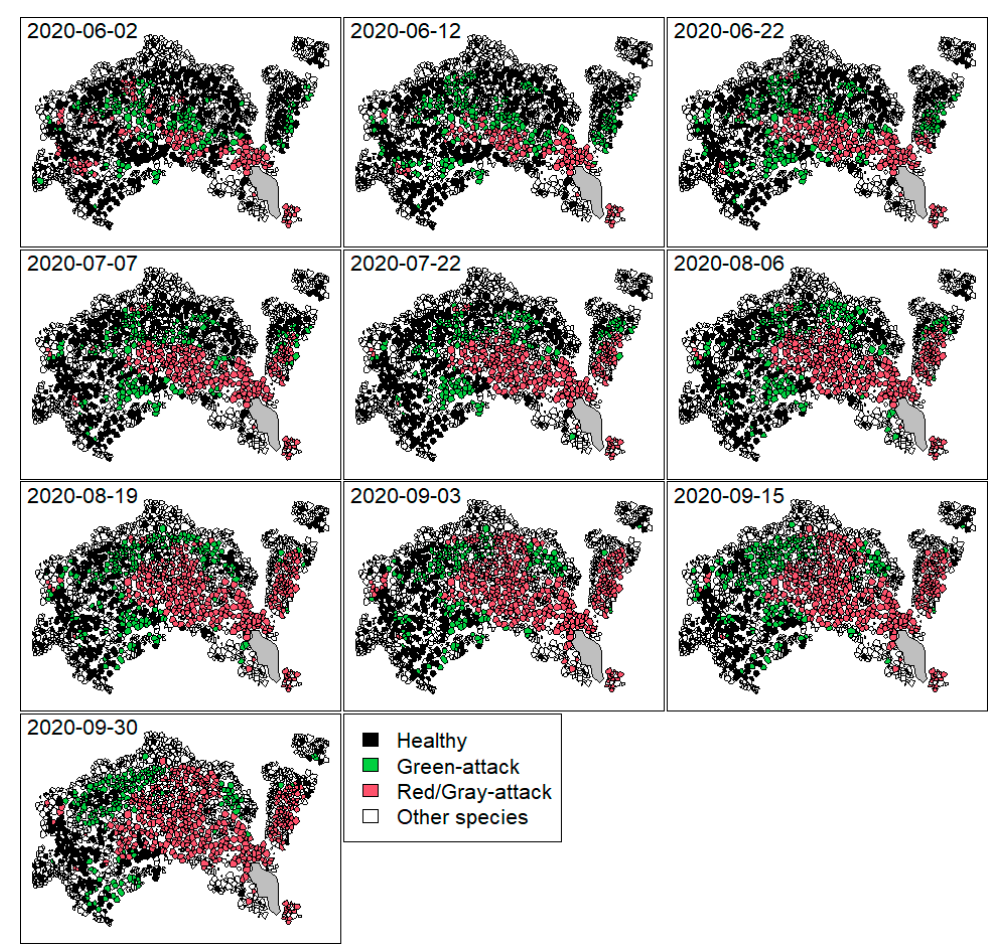
Figure 5. Bark beetle attack mapping obtained from wSVM classification of each S2 image. The grey area on the bottom-right part is an area where a windthrow event happened.